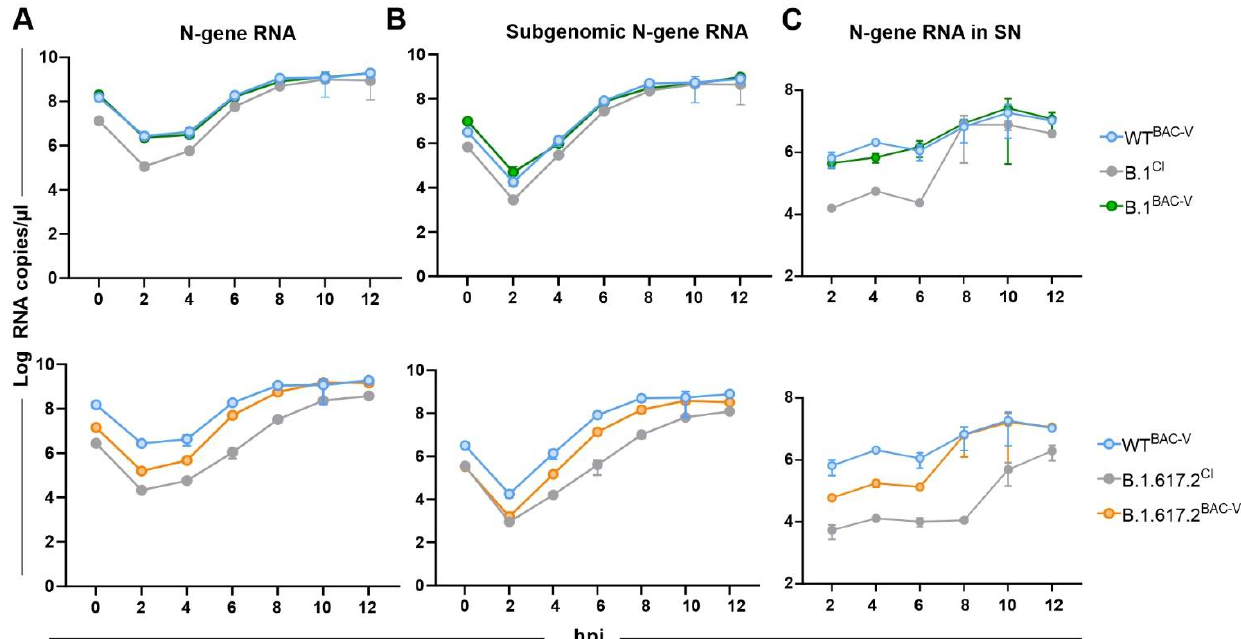
Figure 3. Time course analysis of viral RNA levels in A549-AT cells. ( A ). Total and ( B ). Subgenomic N-gene RNA copies in cells infected with WT BAC-V (blue), B.1 CI (grey, top), B.1 BAC-V (green), B.1.617.2 CI (grey, bottom), and B.1.617.2 BAC-V (orange) at an MOI of 1. The 0 hpi stands for RNA levels in the inoculum used for the infection. ( C ). Total N-gene RNA copies in the supernatant of the cells infected with WT BAC-V (blue), B.1 CI (grey, top), B.1 BAC-V (green), B.1.617.2 CI (grey, bottom), and B.1.617.2 BAC-V (orange) at an MOI of 1. Data are mean ± s.d. of three biological replicates. Statistical comparisons were performed using Welch t -test (Table S2). The experiment was repeated twice yielding similar results. Hours post infection (hpi). Supernatant